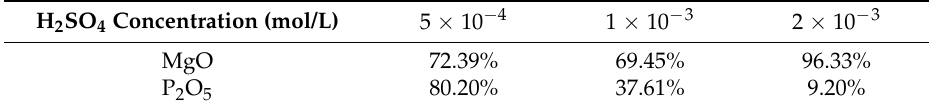
Figure 1. Effect of H 2 SO 4 concentration on the flotation of FA/dolomite with 1 means 1 × 10 − 4 mol/L and 2 means 2 × 10 − 4 mol/L of oleate. Table 1. Effect of H 2 SO 4 concentration on the flotation of FA–dolomite mixture with 2 × 10 − 4 mol/L of oleate.